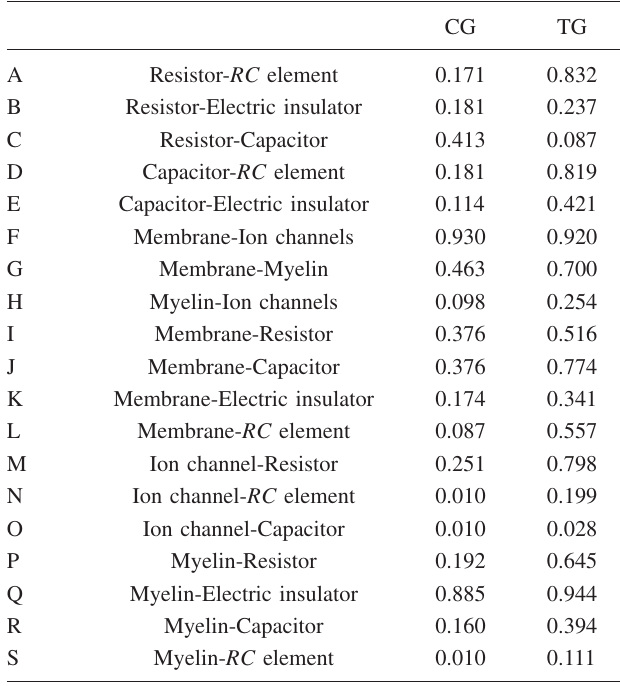
TABLE VII. Means and standard deviations of Cohen’s (cid:8) for different correctors. (cid:8) was calculated for all propositions (cid:1) N =19 (cid:2) .